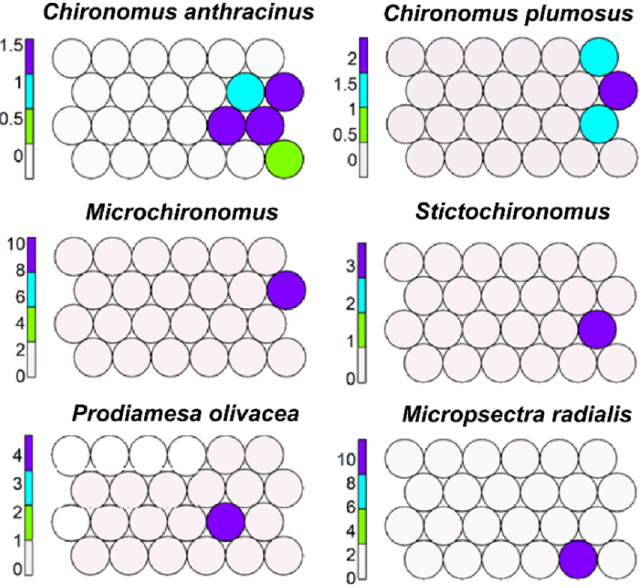
Figure 8. Unsupervised map of six morphotaxa characterizing lake profundals. Tanypus and Paratanytarsus are present in several cells (Figure 9); Parataytarsus includes different morphotaxa that probably live in several habitats, and this explains their dispersed